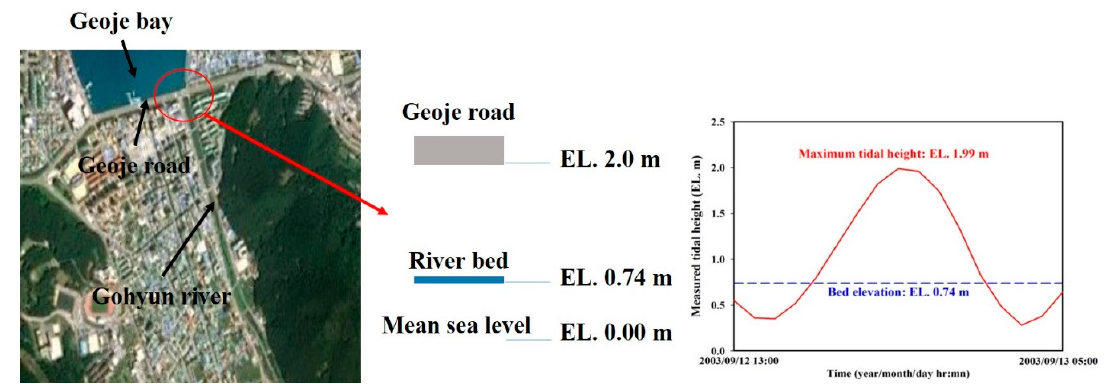
Figure 10. Temporal variation of tide levels during typhoon “Maemi”.